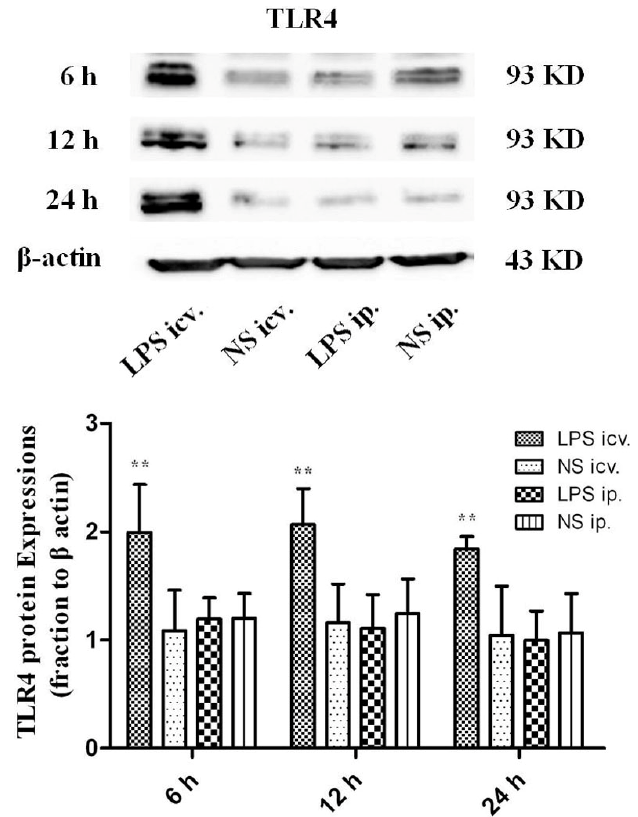
Figure 3. The protein levels of Toll-like receptor 4 (TLR4) in the P1 rat brain 6, 12 and 24 h after intracerebroventricular (icv.) or ip. injections of LPS or NS. At all time points detected, icv. injection of LPS induced dramatic increases of TLR4 protein expression ( ** p < 0.01), compared with those in the peripheral LPS, central NS and peripheral NS injection groups. No significant difference was found in the expression of TLR4 protein in the neonatal rat brains between ip. injections of LPS and NS.